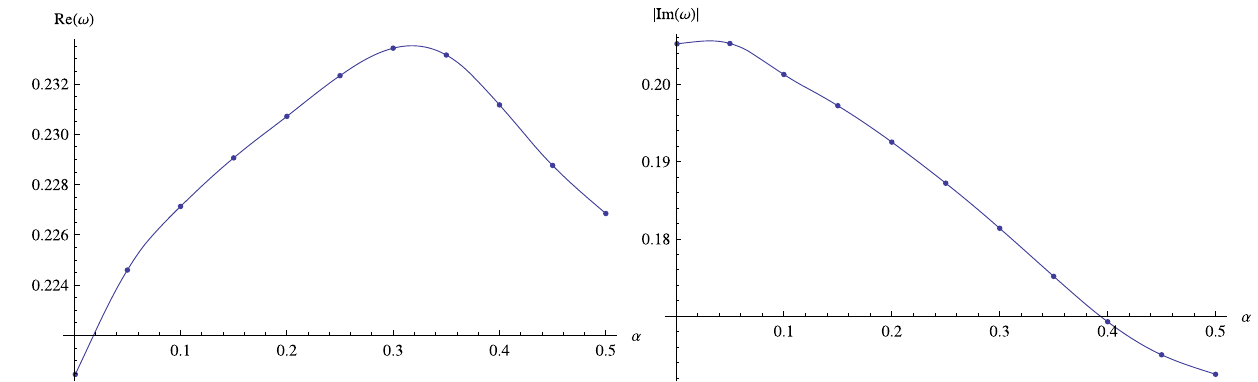
Fig. 1 The fundamental ( n = 0) quasinormal mode computed by the WKB approach for (cid:11) = 0 scalar perturbations as a function of α , M = 1 / 2